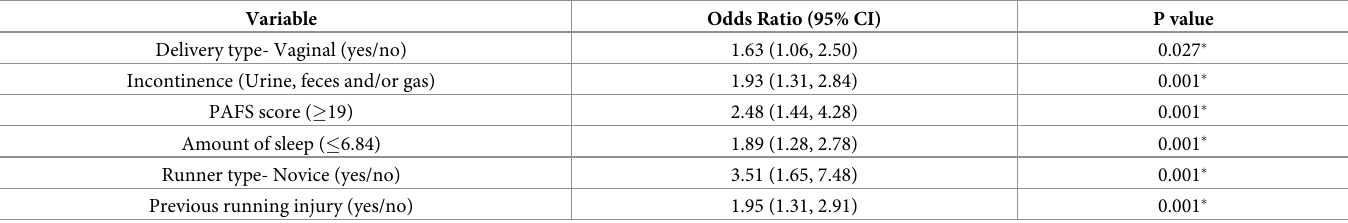
Table 3. Results of final multivariate model (backwards stepwise) demonstrating variables that are associated with current pain with running postpartum (R 2 = 0.161).